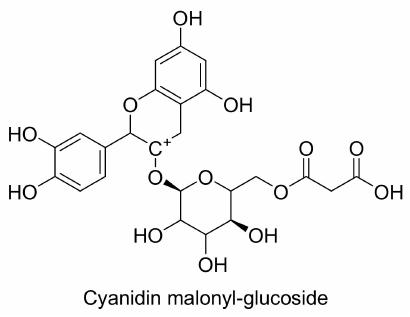
Figure 7. The most potent antiproliferative agent identified in blue